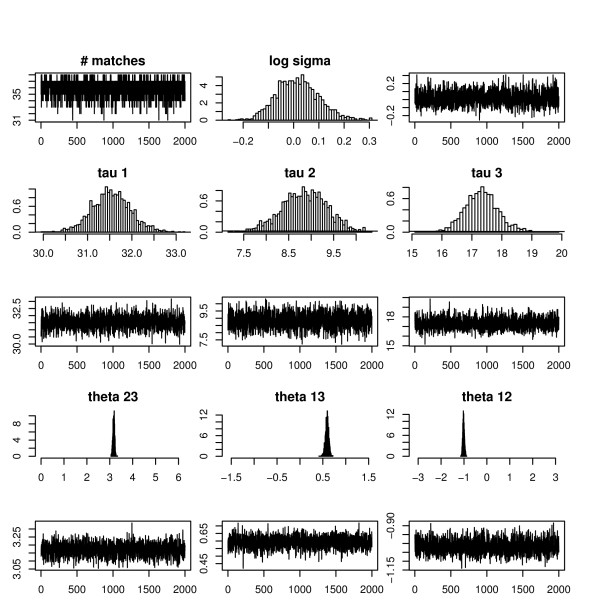
Histograms and traces of parameters when matching 17 – β hydroxysteroid dehydrogenase and carbonyl reductase (1cyd_1).